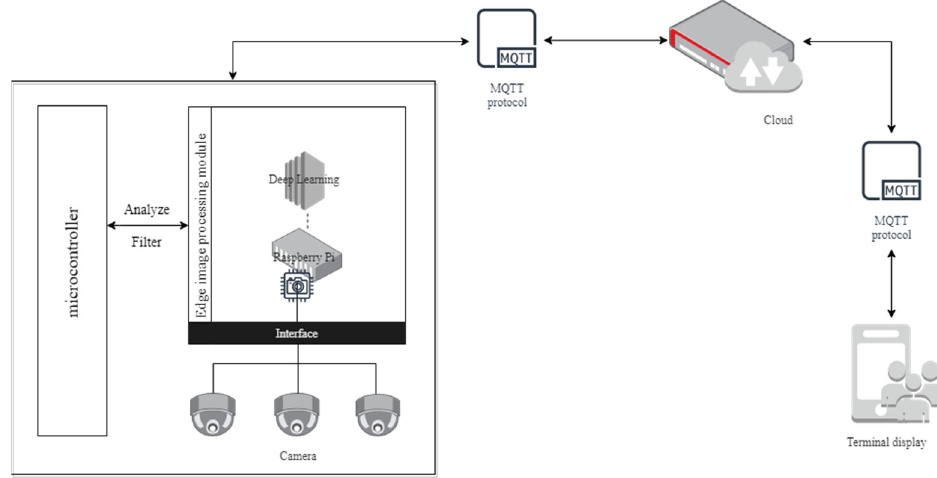
Figure 3. The architecture of edge image processing module.